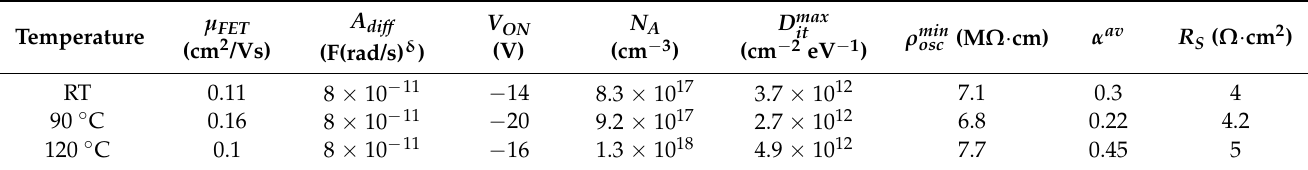
Table 2. Model parameters extracted for OTFTs in BG configuration on SiO 2 /HMDS insulator for different substrate temperatures during OSC deposition.